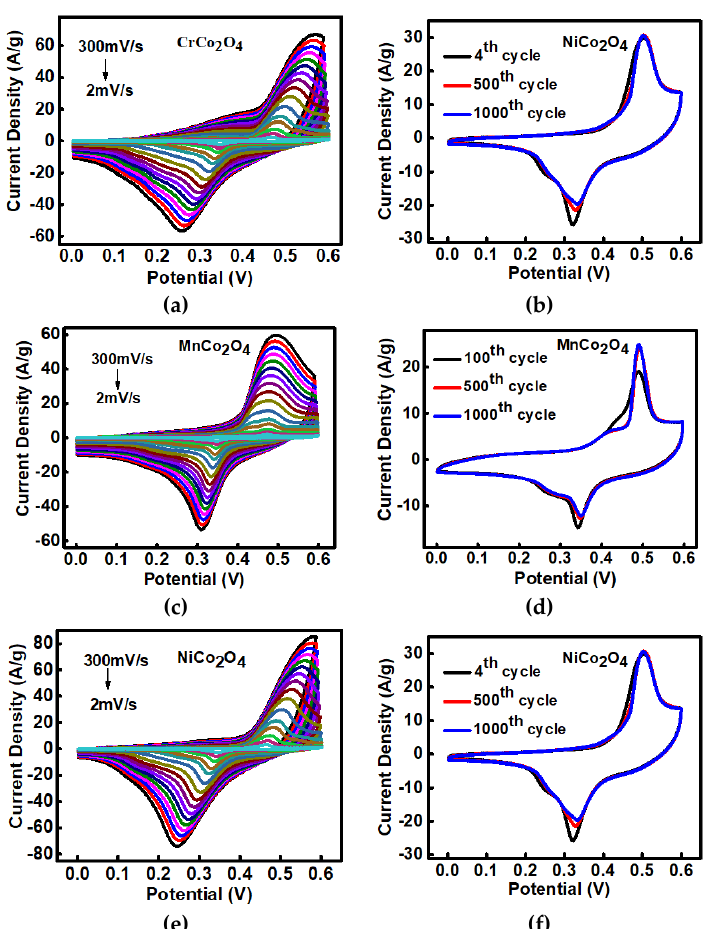
Figure 4. ( a , c , e ) show cyclic voltammetry curves of tubular MCo 2 O 4 (M = Cr, Mn, Ni) electrode obtained in the scan range of 5 mV/s to 300 mV/s measured in 3M KOH electrolyte. ( b , d , f ) show cyclic stability curves measured up to 1000 cycles in 3M KOH electrolyte at scan rate of 40 mV/s. Pseudocapacitive characteristics of electrodes are indicated by a non-rectangular form of CV curves. Within the potential range from 0 to 0.6 V, a pair of reversible redox peaks can be observed.